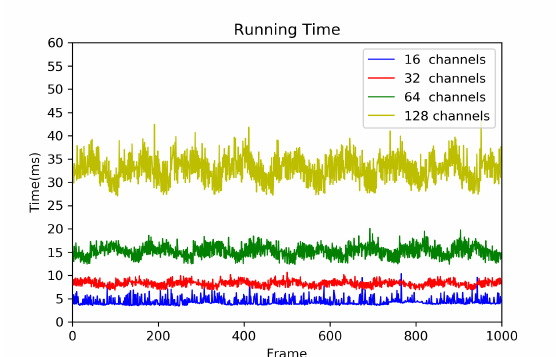
Figure 13. Different LiDAR operation time increases with the number of laser channels, and the time complexity is